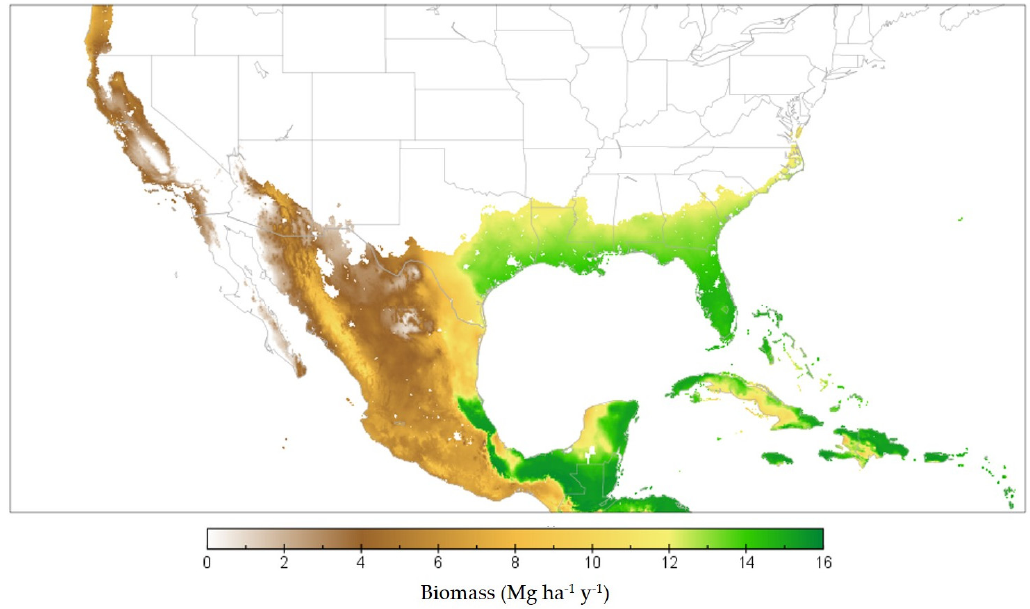
Figure 3. Projections of potential biomass yield (Mg ha − 1 y − 1 ) for Agave americana in North America with current climate conditions and no irrigation.